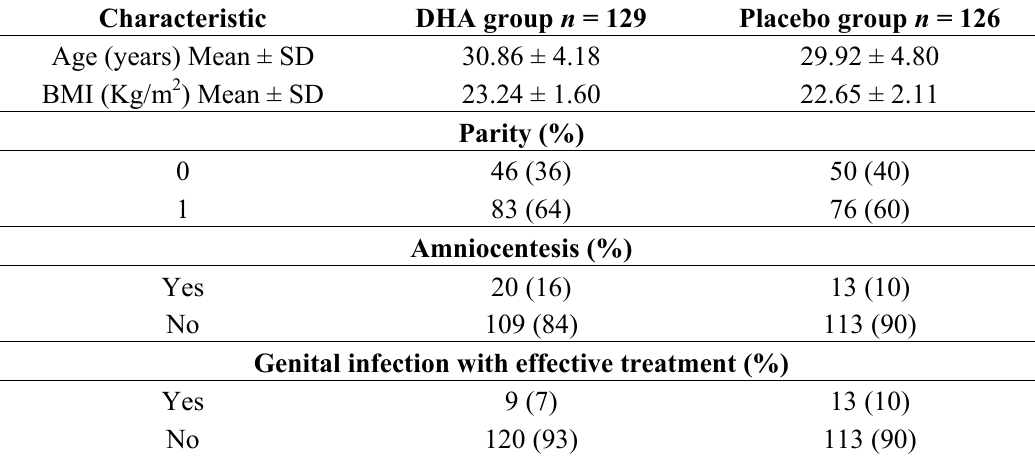
Table 1. Pregnant women personal